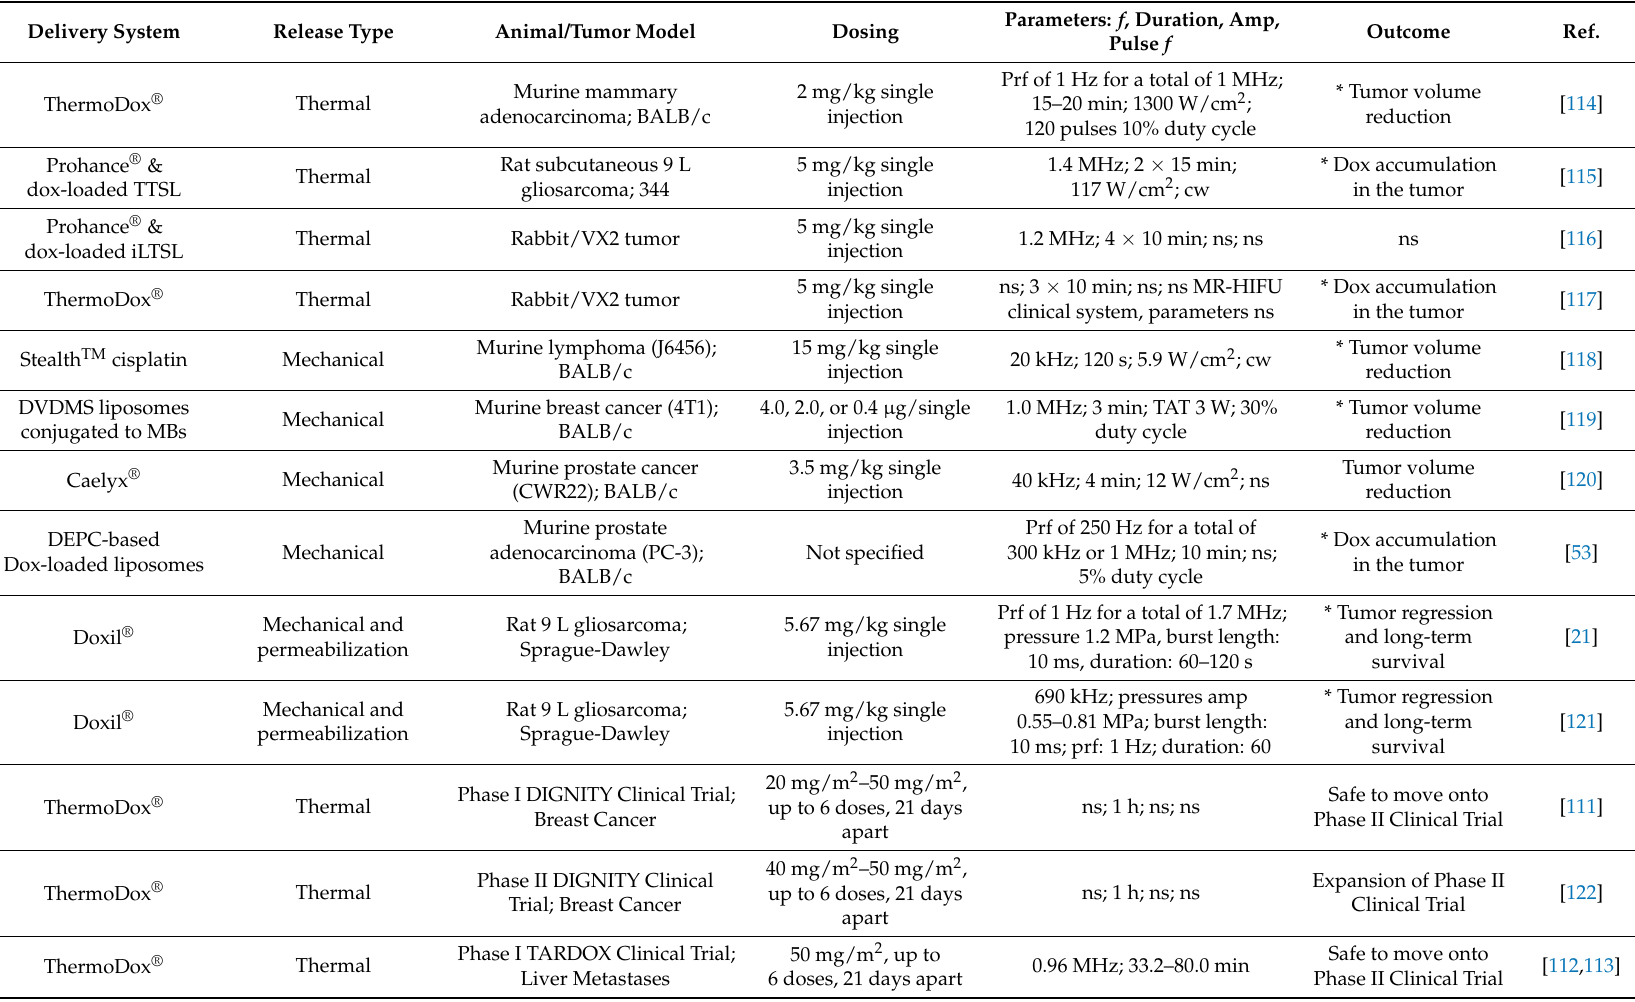
Table 2. Summary of preclinical and clinical cancer treatments for US induced therapy release using liposomes. (Prf = pulse repetition frequency, TAT = total acoustic power, Statistically significant = *, cw = continuous wave, amp = amplitude, f = frequency, ns = not